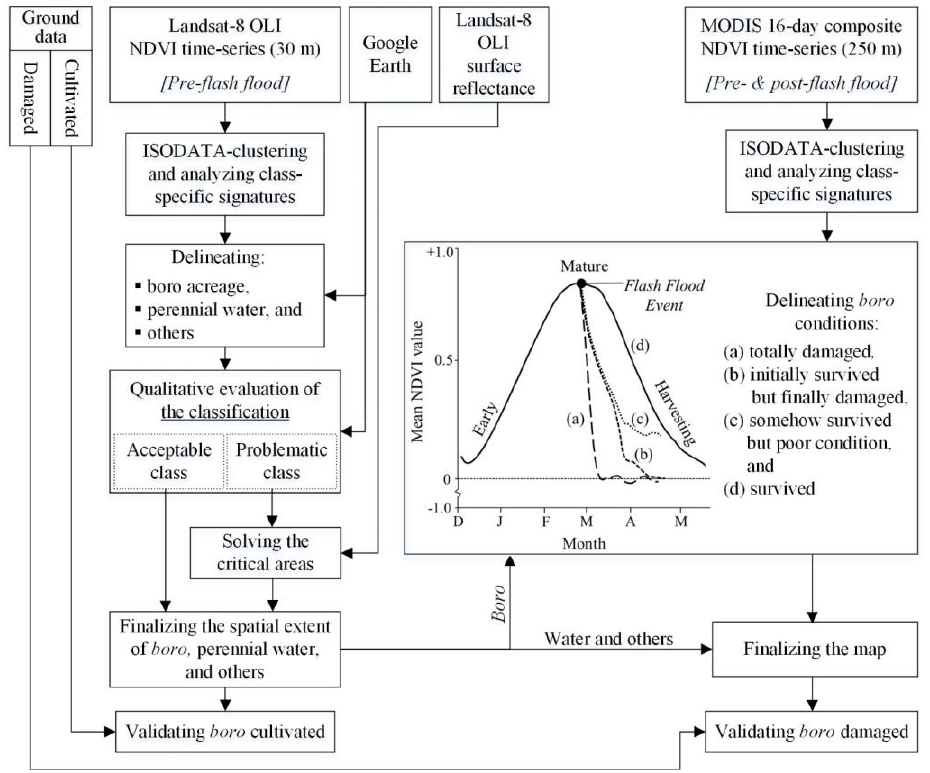
Figure 2. Schematic diagram of the proposed methods and their validation.